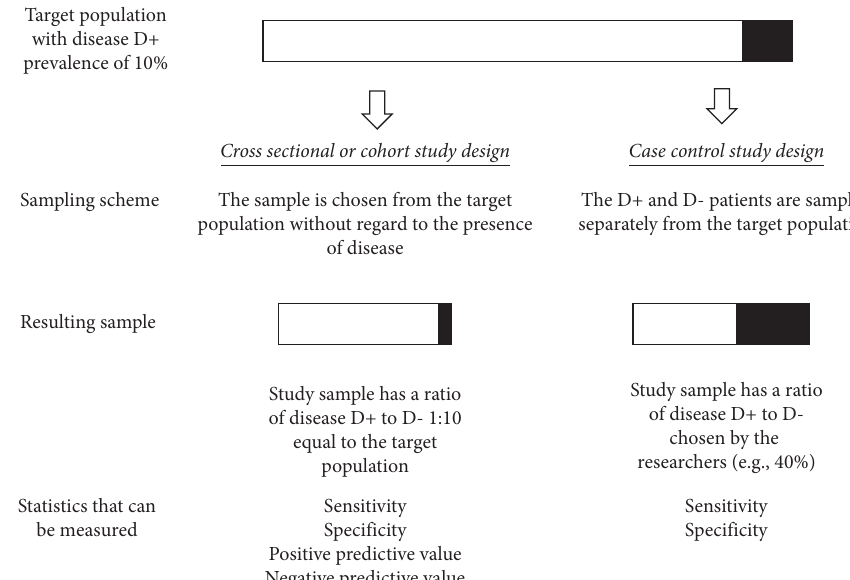
Figure 4: Cross-sectional and cohort designs allow for the calculation of a negative predictive value (NPV) and a positive predictive value (PPV), as they incorporate meaningful prevalence data. D refers to disease status with D+ meaning disease is present and D-patients meaning disease is absent.